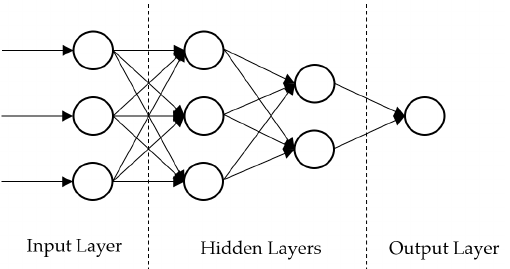
Figure 1. A feedforward neural network with two hidden layers.